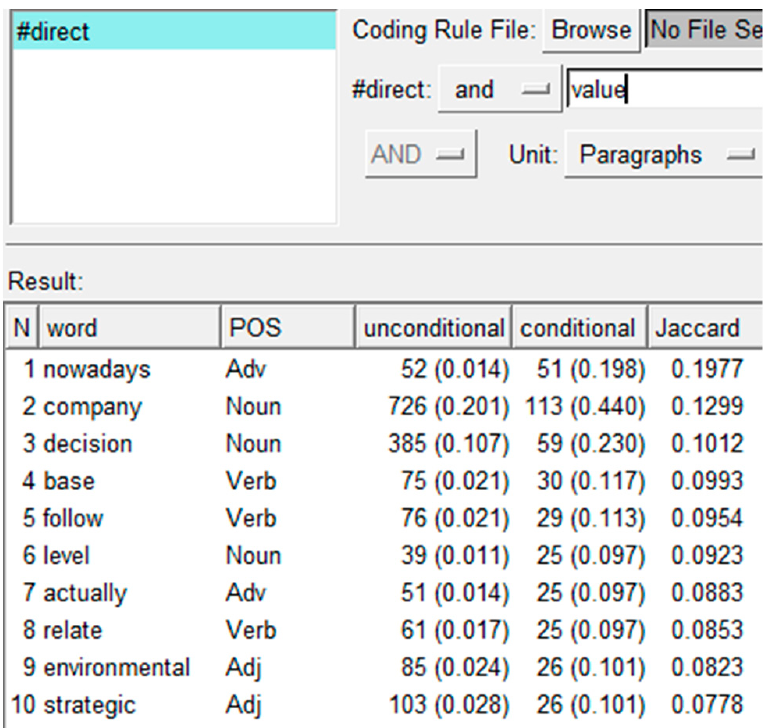
Figure 7. Value word association.